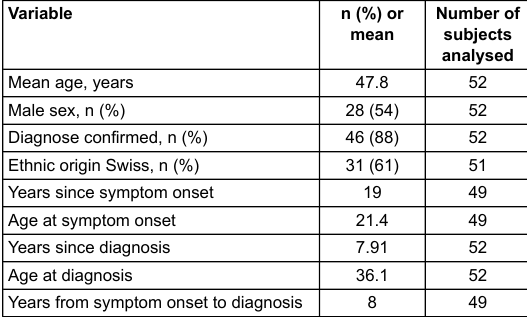
Table 1: Baseline characteristics of the